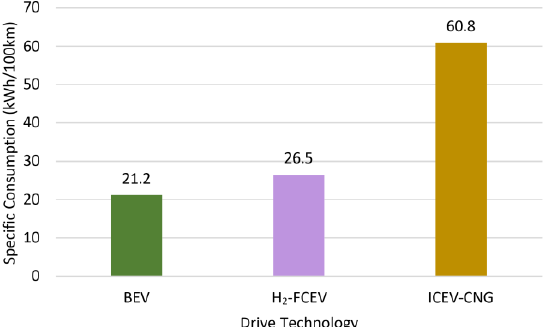
Figure 10. Specific consumption of large passenger vehicles in 2050 as a function of drive technology (transition season, hilly terrain, and WLTP triple-mixed drive cycle).